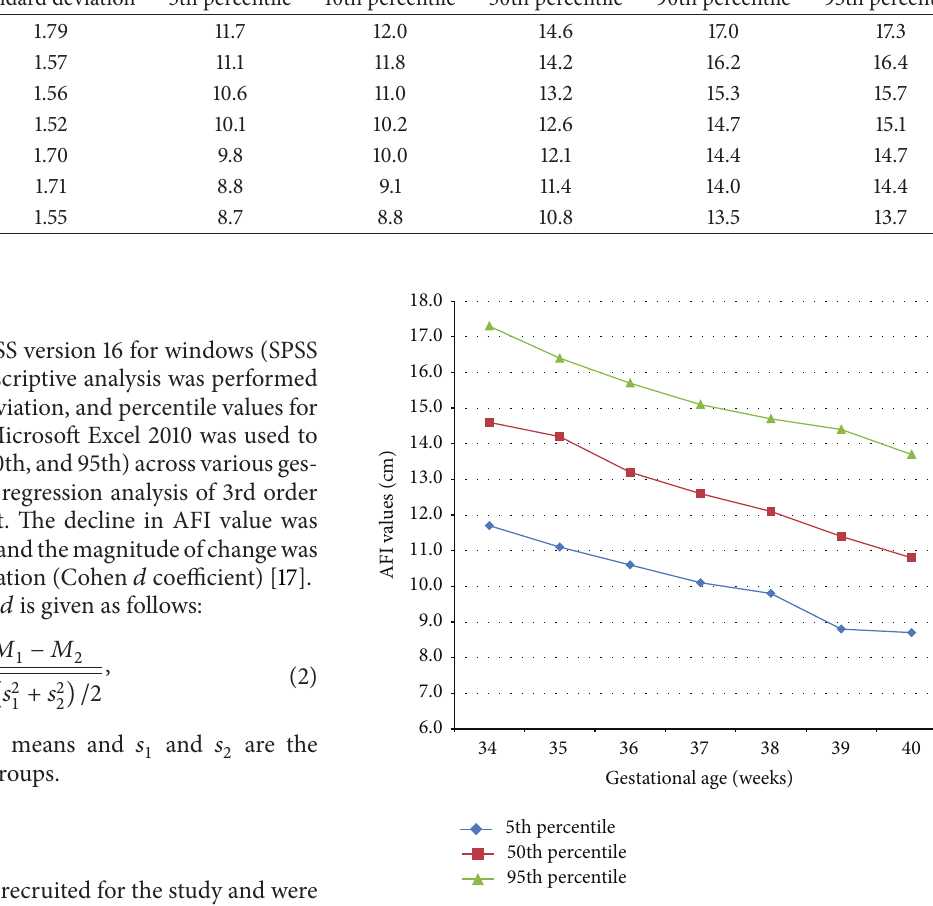
Figure 1: Graphical representation of AFI centiles at various gestational